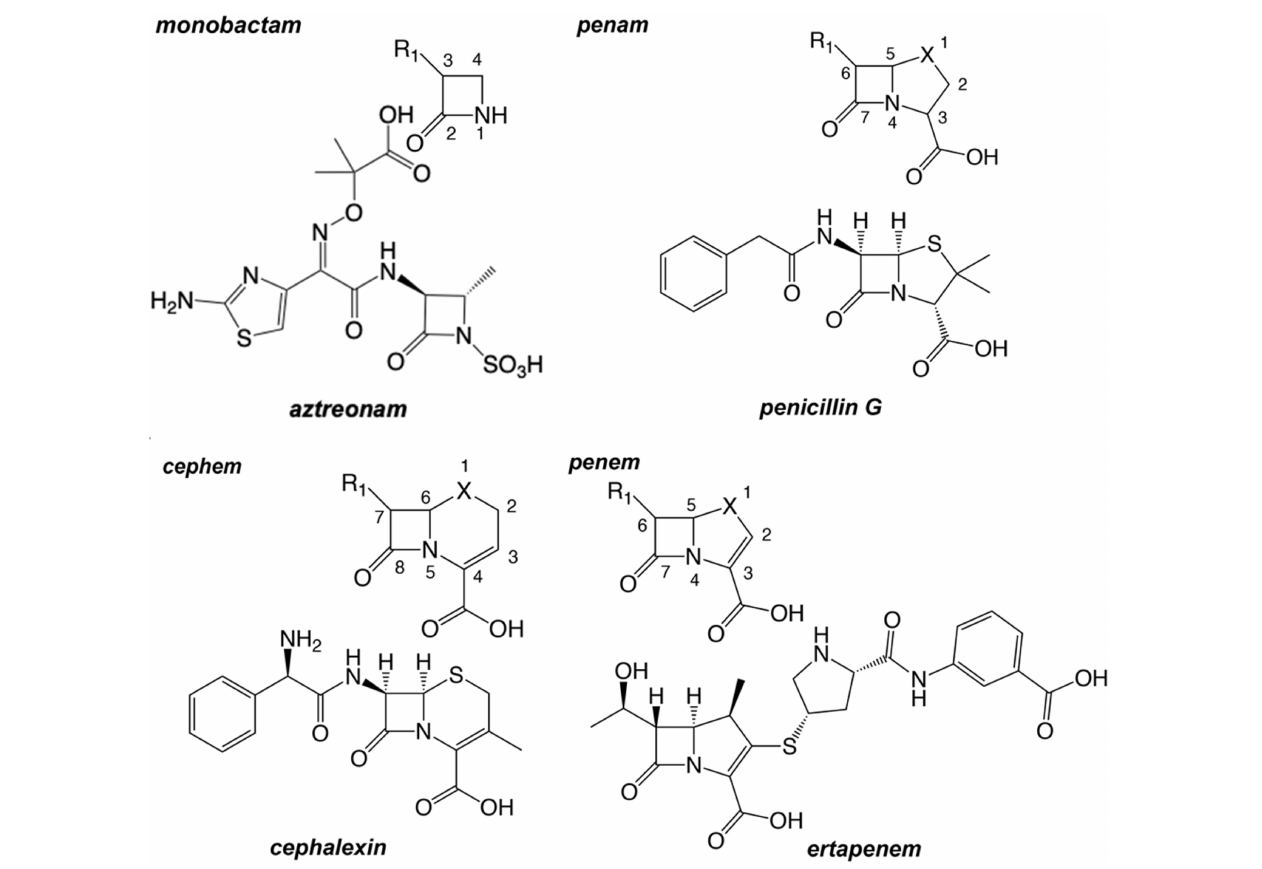
FIGURE 1 | The chemical graphs and scaffold of primary examples of major β -lactam antibiotic classes. Common atom numbering scheme of the chemotype is depicted and oriented above the example β -lactam ring. The X may be a carbon, an oxygen atom, or a sulfur atom. For example, penem structures with X=C